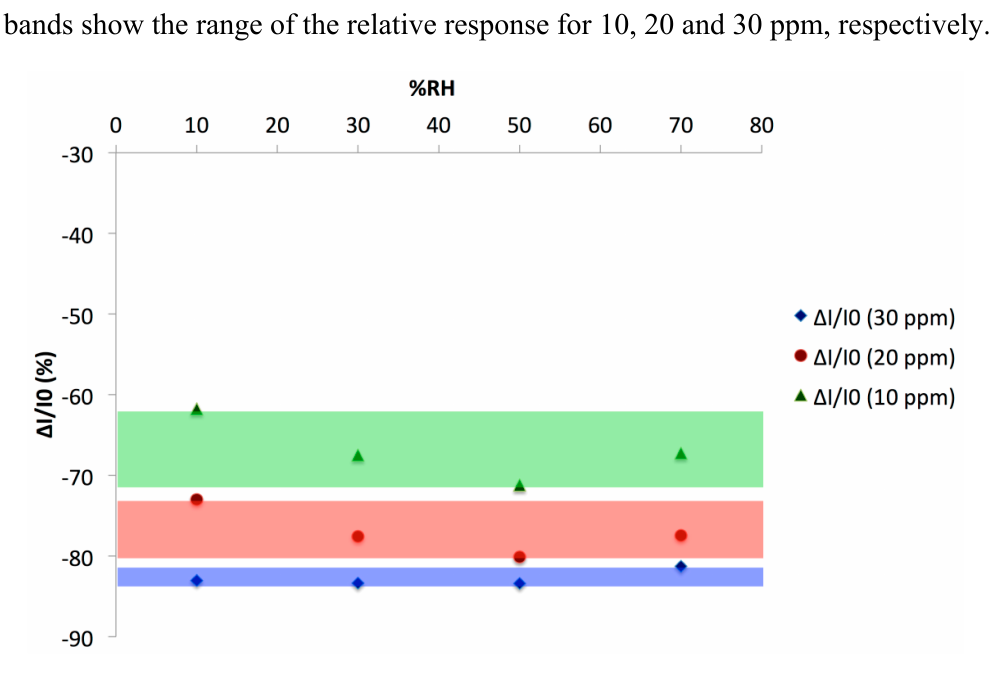
device (E5) exposed to 30 ppm NH 20 3